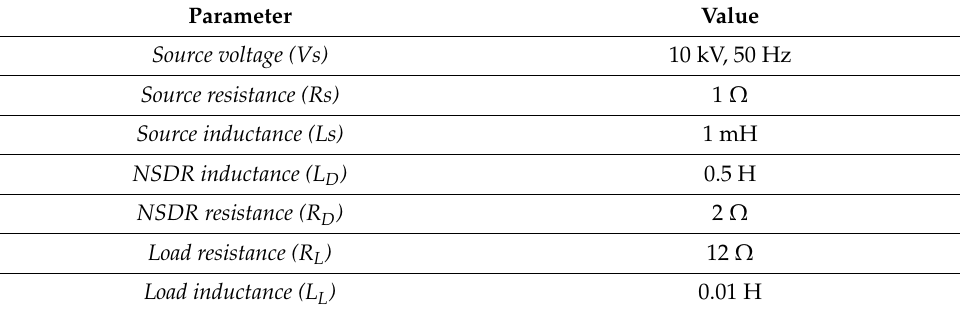
Table 1. Simulated system